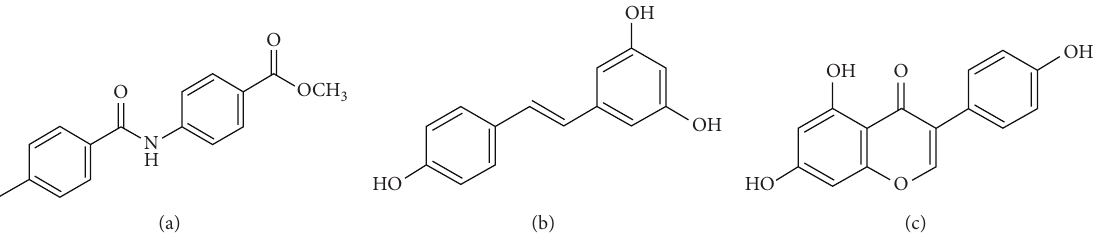
Figure 1: Chemical structure of MBAB (a), resveratrol (b), and genistein (c).